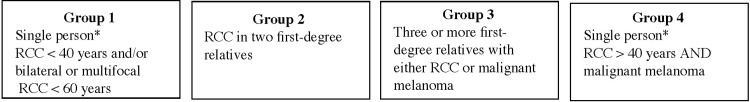
Schematic presentation of the organization of the participating families into four groups.The organization is based on clinical data. In group 1 one family member was affected with RCC (n = 20) either RCC < 40 years of age and/or bilateral or multifocal RCC < 60 years of age, in group 2 two family members were affected with RCC (n = 21), in group 3 more than two family members were affected with RCC and/or melanoma (minimum of one RCC) (n = 17) and in group 4 the proband had been diagnosed with both melanoma and RCC (n = 5) comprising sixty-three family members in forty-eight families. *No affected first-degree relatives with RCC or malignant melanoma.